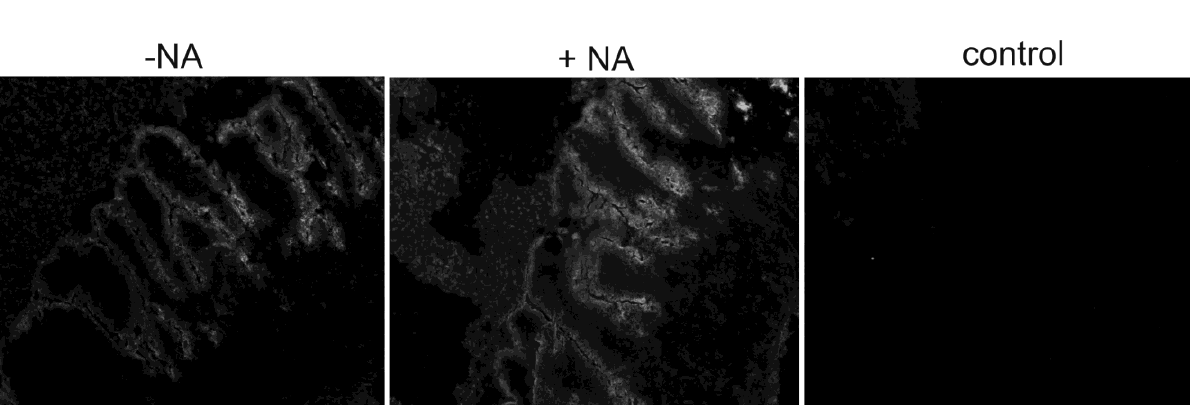
Figure 5. Binding test of soluble TGEV spike protein on cryosections of porcine jejunum: cryosections were either pretreated (+NA) or not treated (-NA) with 300 mU neuraminidase prior to binding of soluble spikes. The control cryosections were incubated only with the fluorescence dye (CY3) labeled secondary antibody. No decrease in the binding of TGEV spikes was observed after neuraminidase